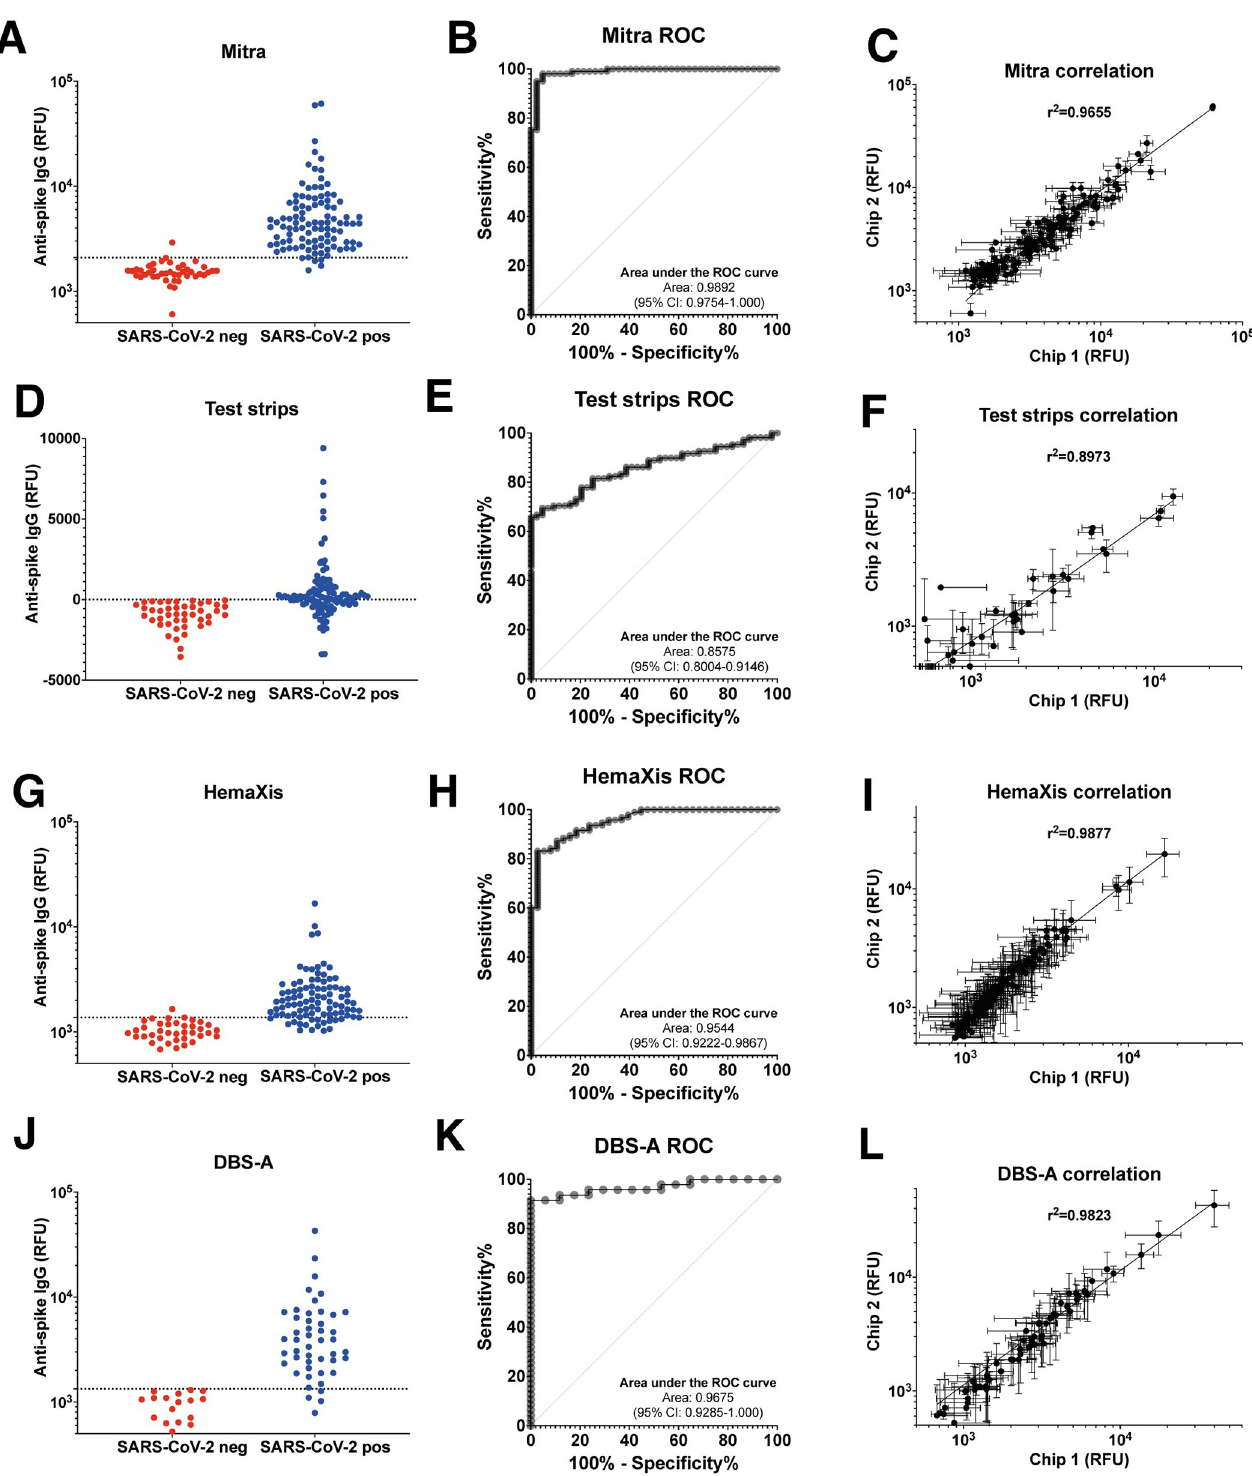
Fig 3. Performance of microfluidic nano-immmunoassay (NIA) test using dried blood microsamples. Signal intensities with positivity threshold (dotted line), ROC curve, and chip-to-chip correlation for the microfluidic nano-immunoassay testing of dried blood samples collected on Mitra (A-C), (glucose) test strips (D-F), or HemaXis microsampling devices (G-I), and after automated extraction by flow-through desorption of dried blood spots (DBS-A) (J-L).